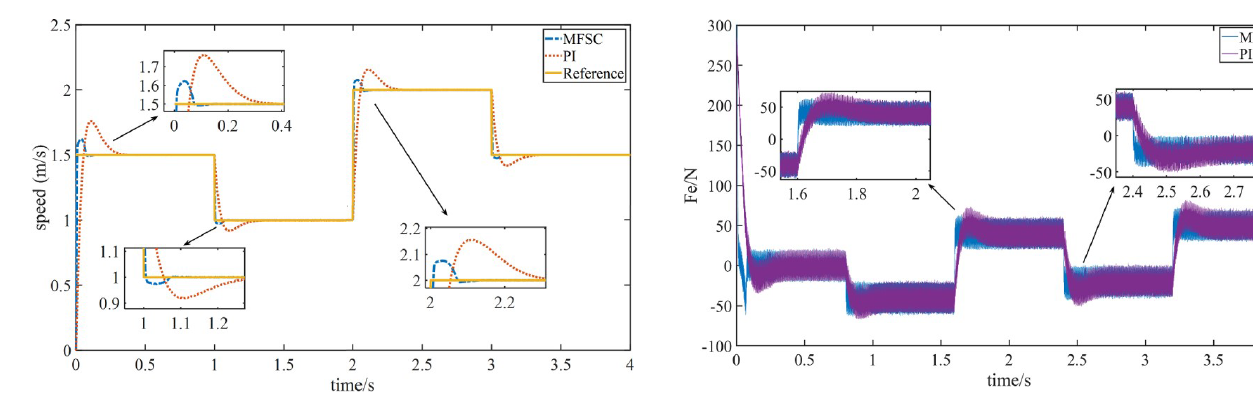
Figure 6. Variable speed motion test of two controllers.